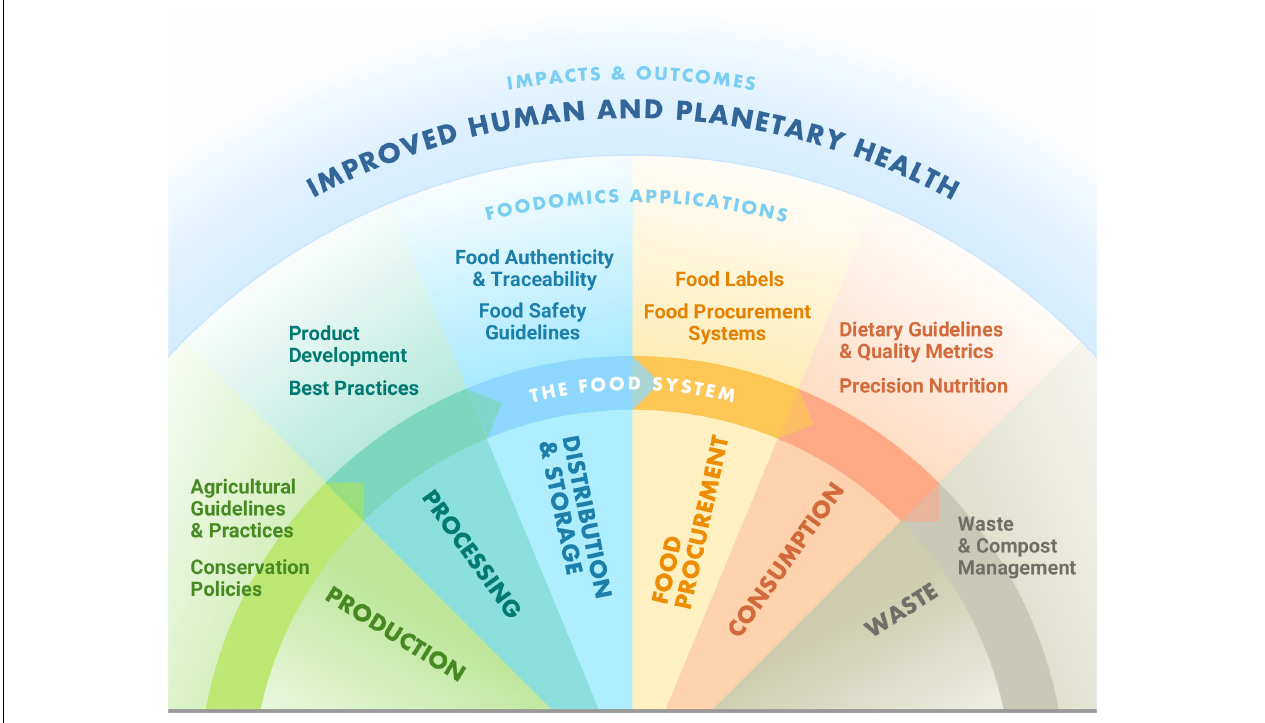
FIGURE 1 | Application of foodomics across the food system. Foodomics can be applied across the food system to enhance human and planetary